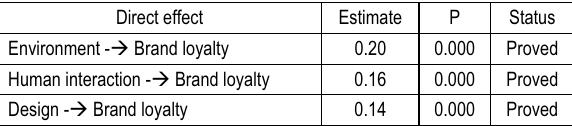
Table 8. Indirect standardized regression coefficient